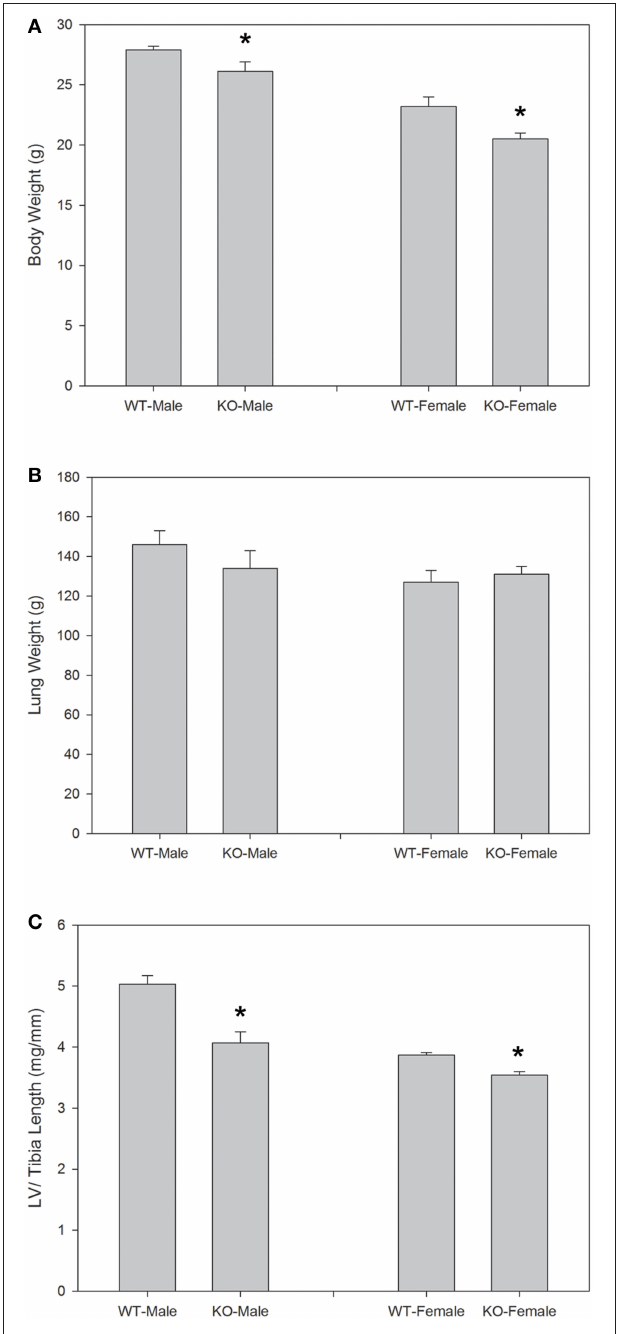
FIGURE 1 | Body weights (A), lung weights (B), and left ventricular (LV) weights normalized for tibia length (C), for the animals used in the P-V loop measurements. Sexes are considered separately, and body weights as well as LV weights show significant differences between WT and KO animals for each sex. In the case of LV weights, the significance remains, when sexes are combined. n = 7 for both sexes together. * indicates statistically significant difference between KO and WT